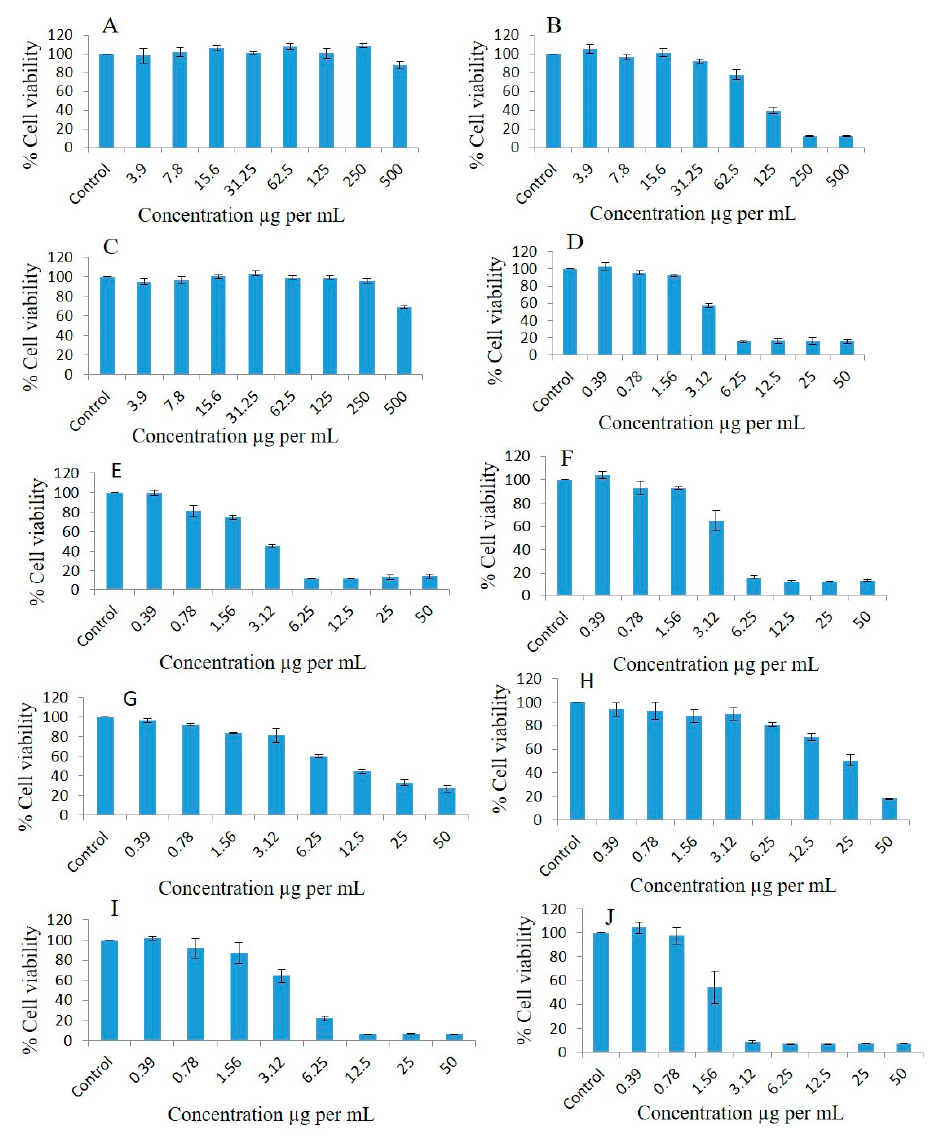
Figure 7. Effects of different concentrations of pure FSO ( A ), BSO ( B ), ZRO ( C ), F4- systems-loaded RMV ( D ), F4-systems-loaded BRB (E), F4-systems blank (drug free systems) ( F ), pure BRB ( G ), pure